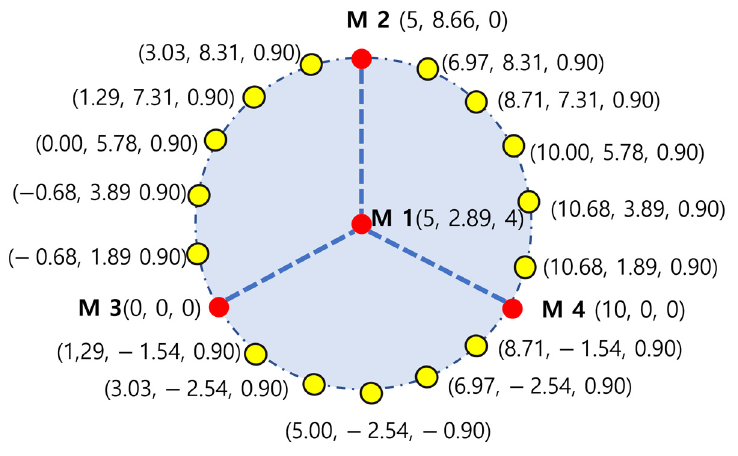
Figure 10. Geometry of construction site validation test 1.